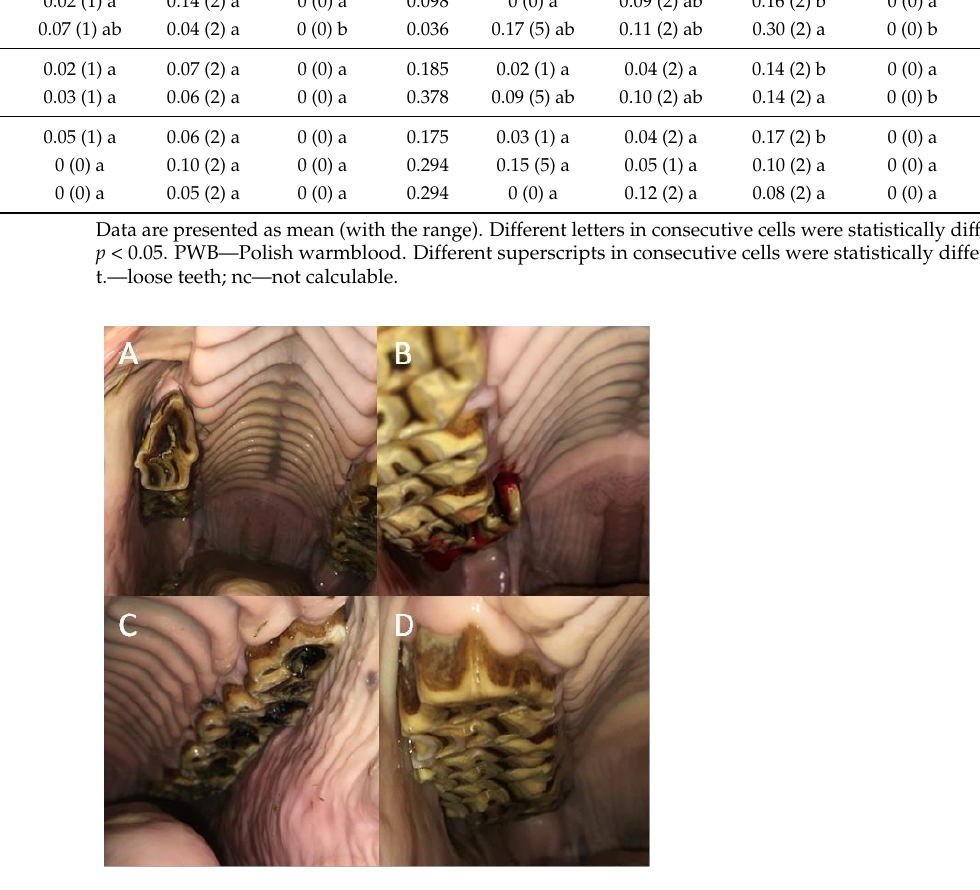
Figure 7. The samples of the dental diseases of the premolar and molar teeth in horses. Loose teeth ( A ); fractures ( B ); caries ( C ); and calculus ( D ).